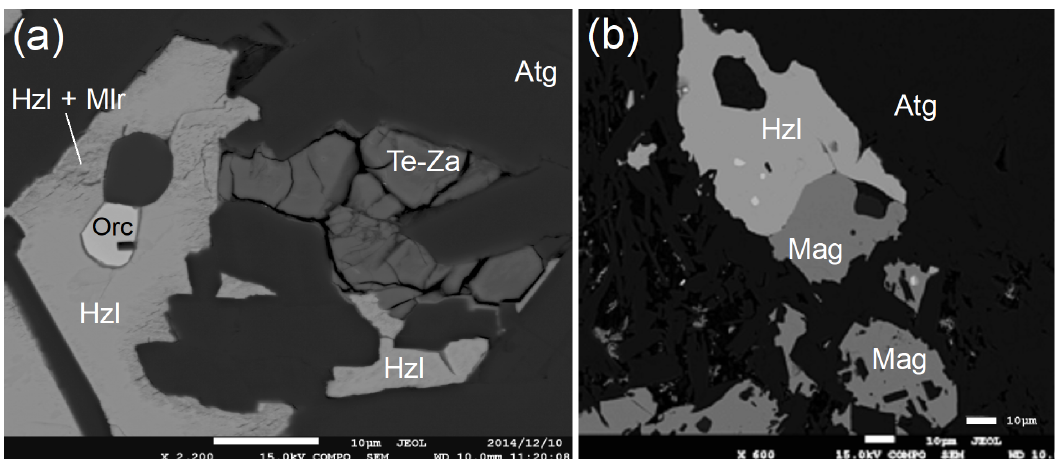
Figure 5. SEM images of heazlewoodite and related minerals. ( a ) Theophrastite-zaratite aggregate (Te-Za) associated with heazlewoodite. Note the inclusion of orcelite (Orc; arsenide) which contains am antigorite lath. Hzl, heazlewoodite. Mlr, millerite. Atg, antigorite. ( b ) Magnetite (Mag) associated with heazlewoodite. Note that the antigorite laths included by Hzl and Mag. Bright dots in Hzl are